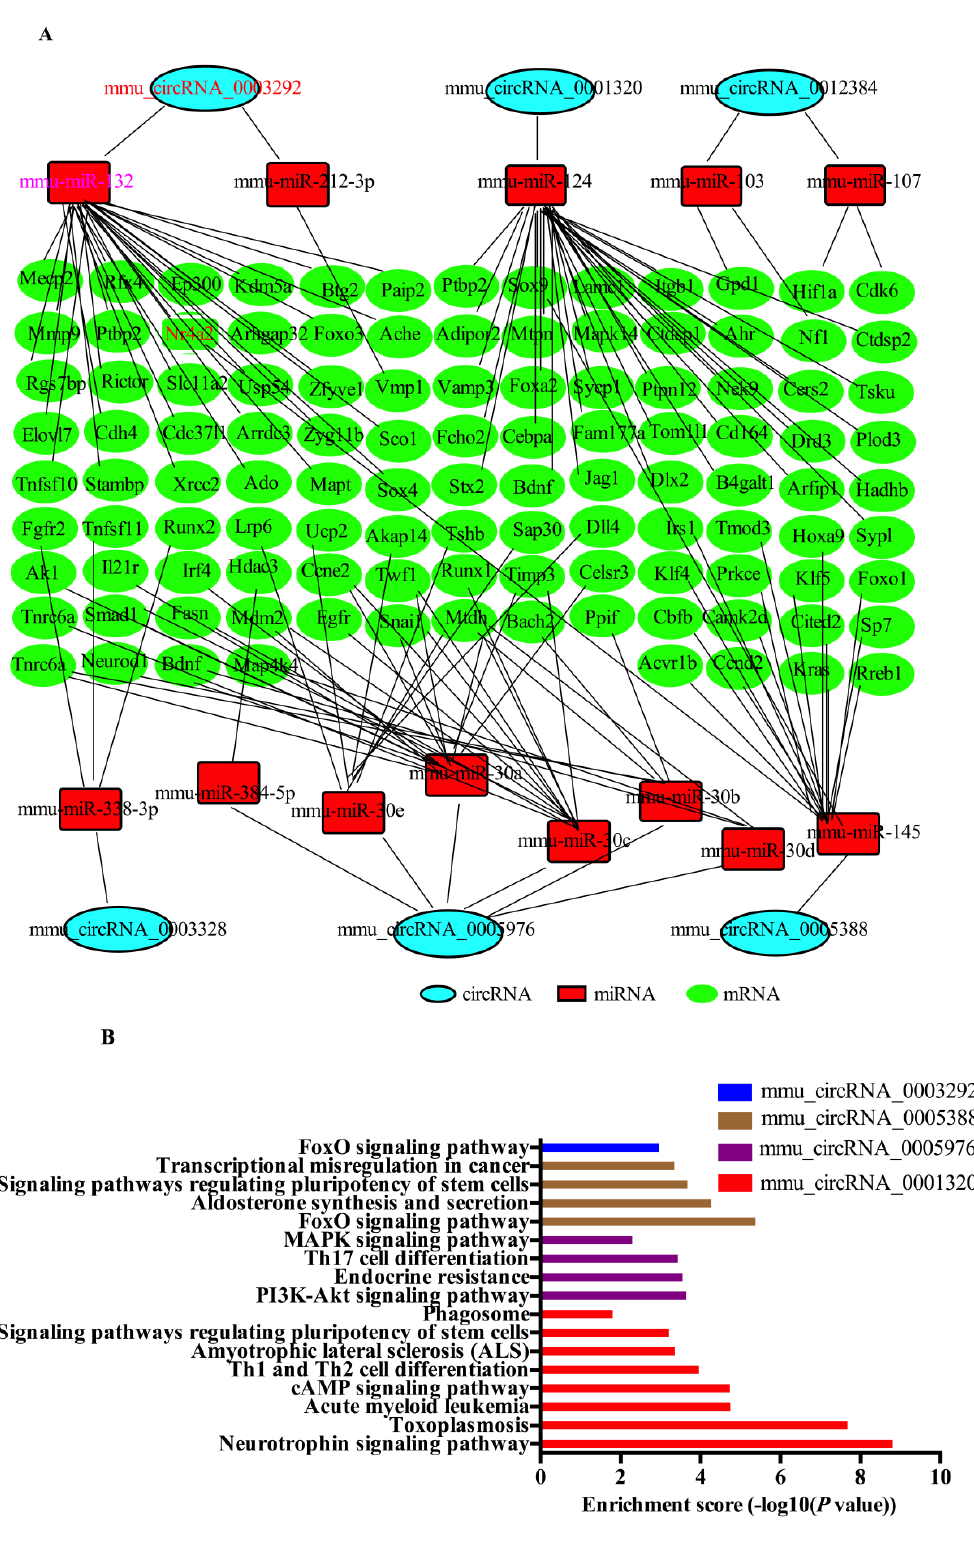
Figure 6. Prediction of DE-circRNAs-targeted genes based on TargetScan and miRTarBase. ( A ) The six predicted circRNAs-targeted circRNA–miRNA–mRNA networks. ( B ) The enriched Kyoto Encyclopedia of Genes and Genomes (KEGG) pathways of the DE-circRNAs targeted